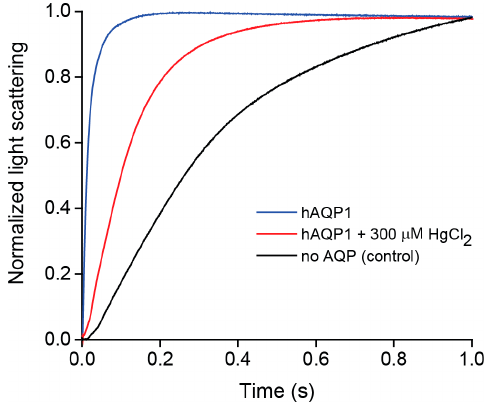
Figure 2. hAQP1 water permeability functional assay. Normalized light scattering intensity changes of hAQP1— E. coli lipid proteoliposomes ( blue trace) compared with no-AQP liposome control ( black trace) in response to an osmotic shock, and inhibition of hAQP1 proteoliposomes by mercuric chloride ( red trace). The average fitted rate constants ( k ) (means ± S.E., n = 6) measured at 23 °C for hAQP1-proteoliposomes, proteoliposomes in presence of 300 µM HgCl 2 and no-AQP liposomes were 109.4 (±1.9), 8.56 (±0.03) and 2.27 (±0.04) s − 1 , respectively.